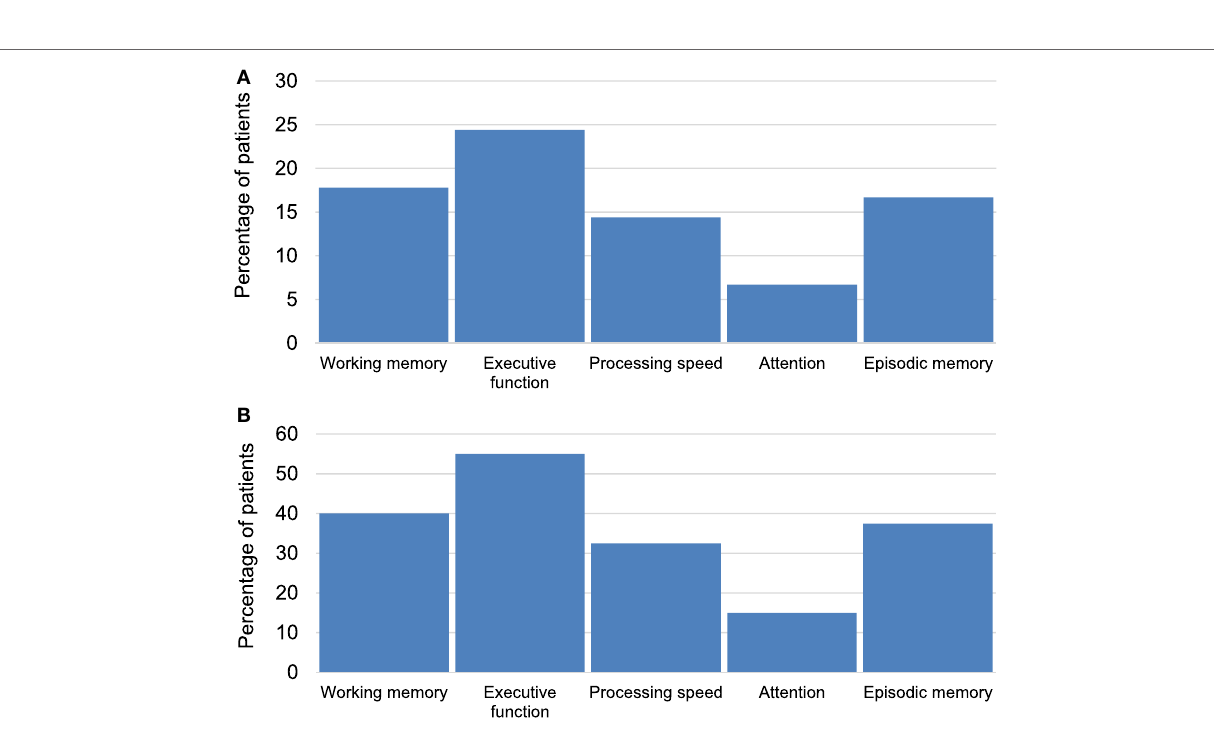
FigUre 3 | (a) Percentage of multiple sclerosis (MS) patients with impairment in specific cognitive domains across the whole sample ( n = 90). (B) Percentage of MS patients with impairment in specific cognitive domains among the impaired group ( n = 40).